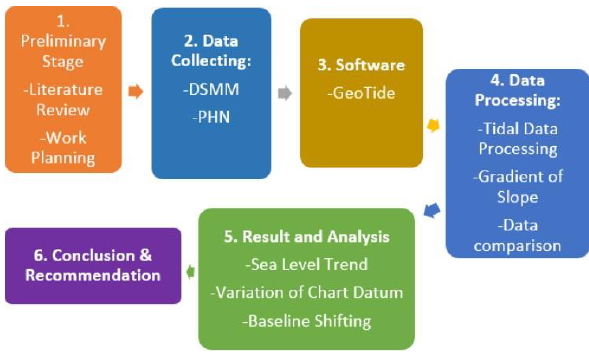
Figure 5 . Data Processing for GeoTide